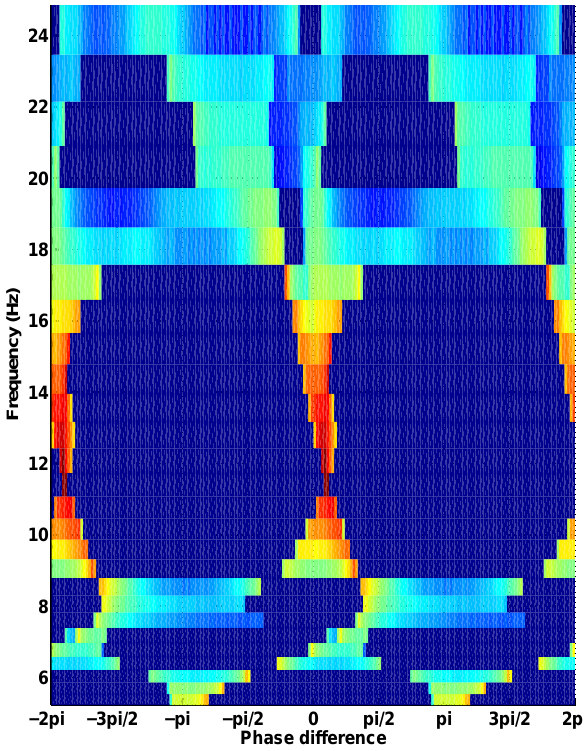
Fig. 5. The electric field waveforms E 13 and E 42 (top panel) and E 41 and E 23 (lower panel) for the first event.